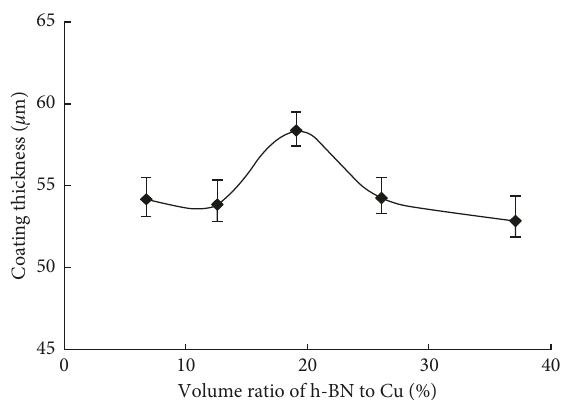
Figure 10: Effect of the volume ratio of h-BN to Cu on coating thickness (capacitance is the 3rd grade, and deposition time is